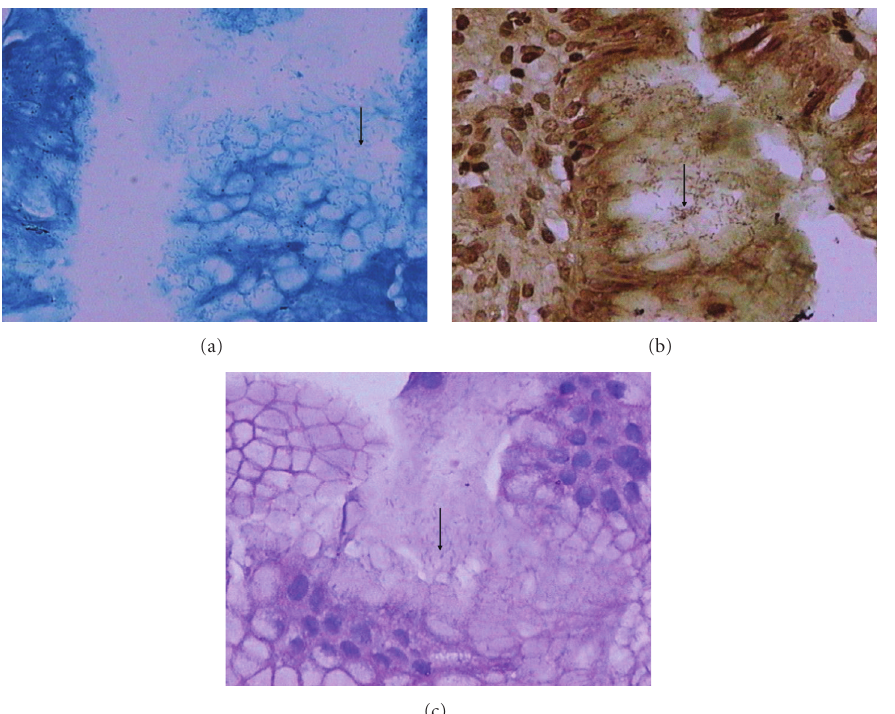
Figure 3: H. pylori aggregation on the surface of gastric mucosa. H. pylori was detected as (a) light blue staining using toluidine blue, (b) brownish-black staining using Warthin-Starry silver, and (c) light purple using H&E. Arrows indicate H. pylori bacilli . Magnification,